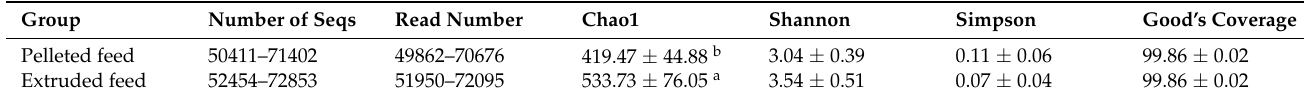
Table 7. Number of reads, statistical estimated community richness index (Chao1), community diversity indexes (Shannon and Simpson), and Good’s coverage for 16S rRNA libraries of P. clarkii intestinal microbial ecosystems.